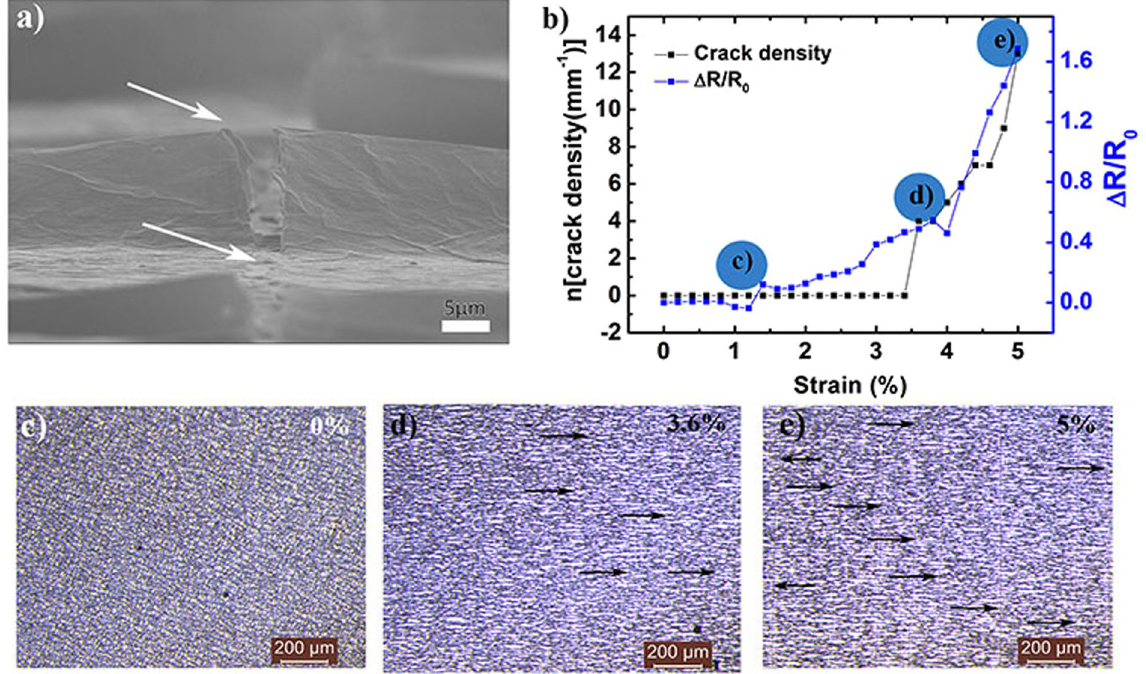
Figure 5. ( a ) Cross-section SEM image of 3-coat sample under 5% strain. The image was obtained after resolving the crack at extended depth of focus. The two arrows indicate the crack formation across the buckle and in the planar region of the sample. ( b ) Variation in crack density (n) and fractional resistance as a function of strain. ( c , d and e ) Optical images of 3-coat sample at 0, 3.6 and 5% applied strain, respectively. Blue labeled circles in Fig. 5(b) correspond to the optical images shown in ( c – e